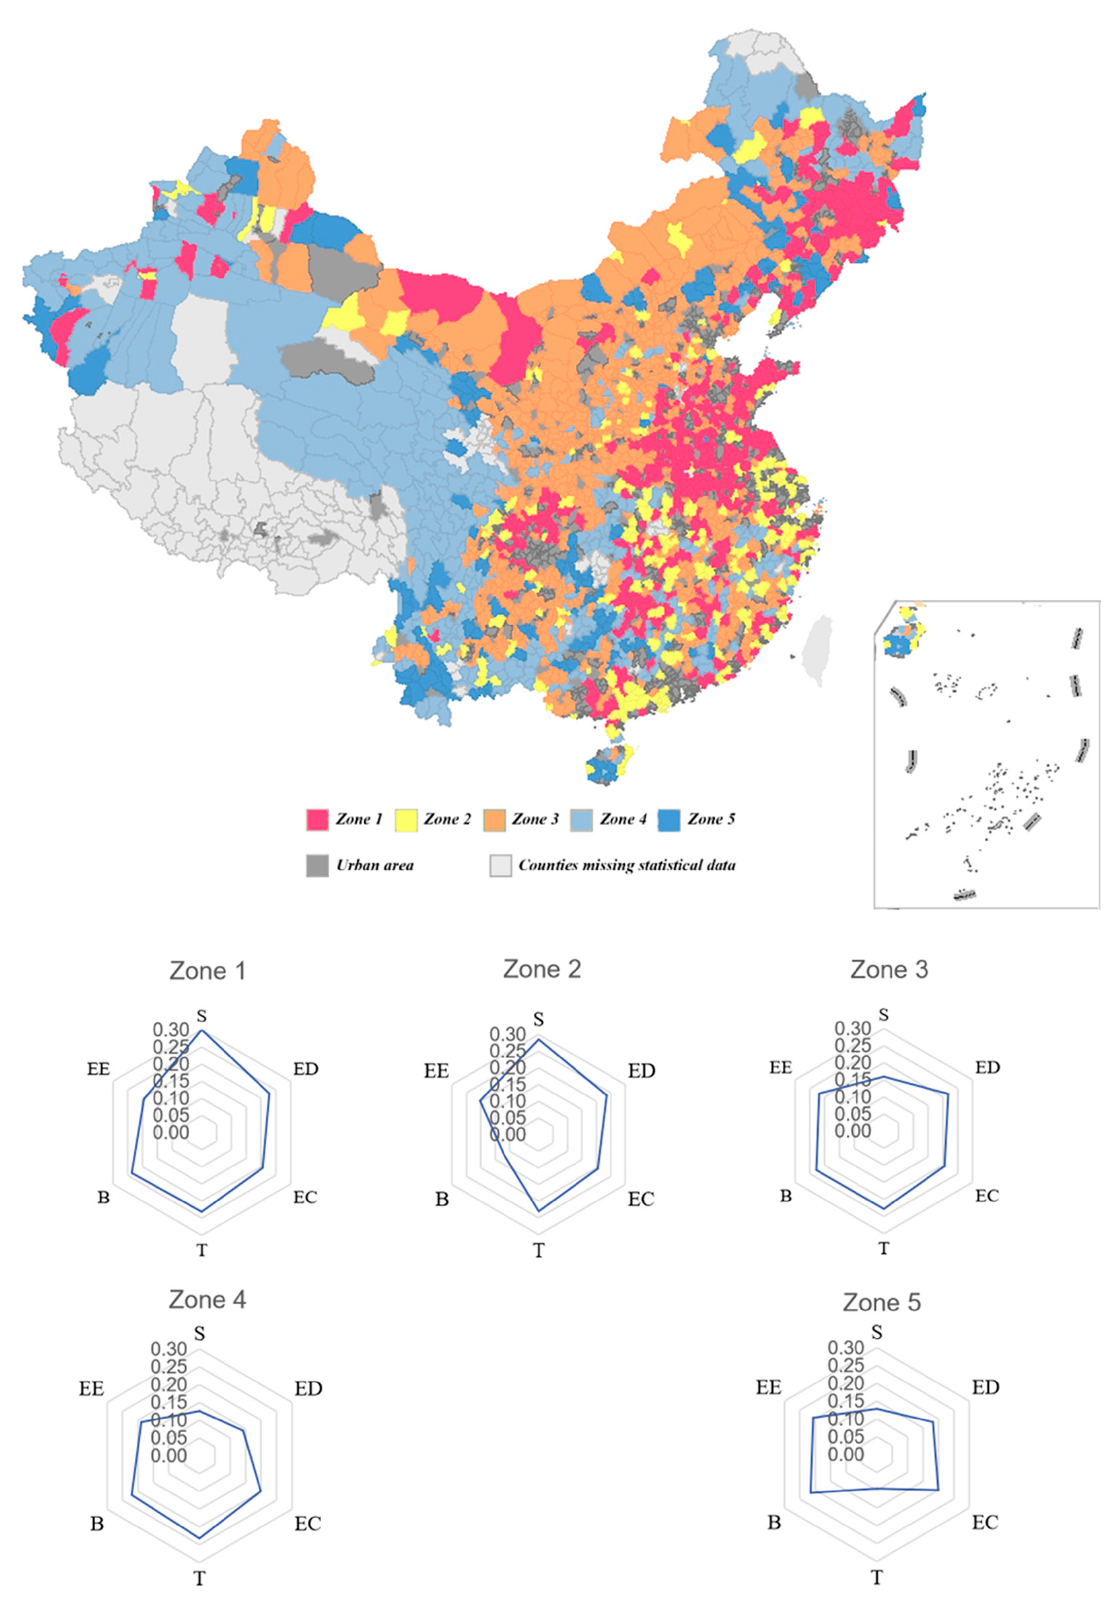
Figure 4. Map of county-level carbon emission governance zones.